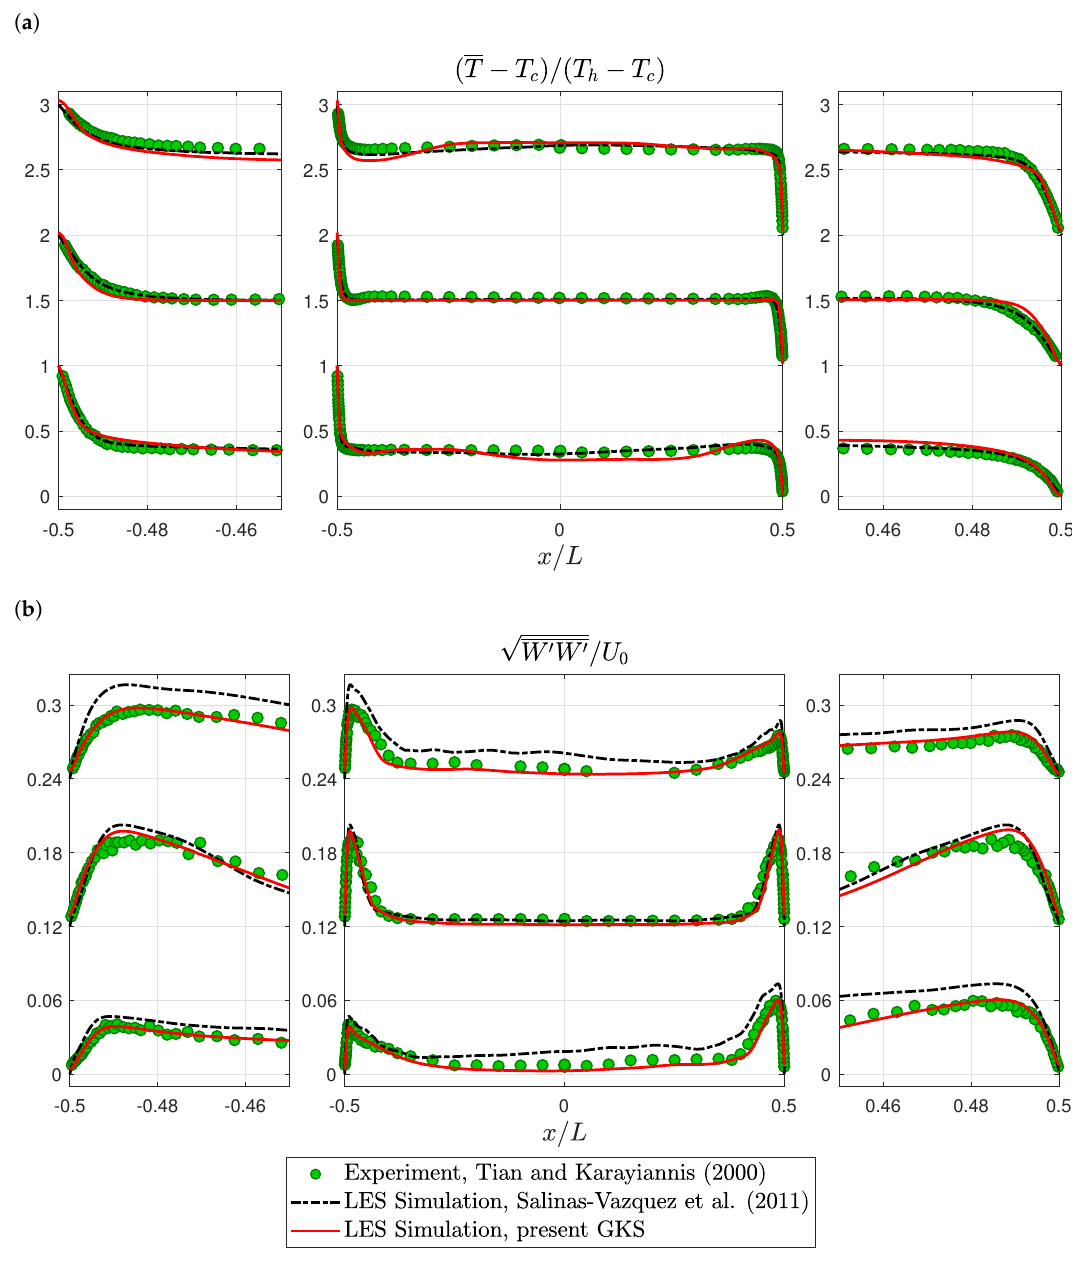
Figure 6. 3D square cavity: temperature and velocity fluctuation profiles at heights z / L = 0.1, z / L = 0.5 and z / L = 0.9 from bottom to top: ( a ) Temperature profiles. For visualization, the profiles are shifted by one. ( b ) Vertical velocity fluctuation profiles. For visualization, the profiles are shifted by 0.12. Experimental values from Tian and Karayiannis [70] and simulation values from Salinas-Vázquez et al.